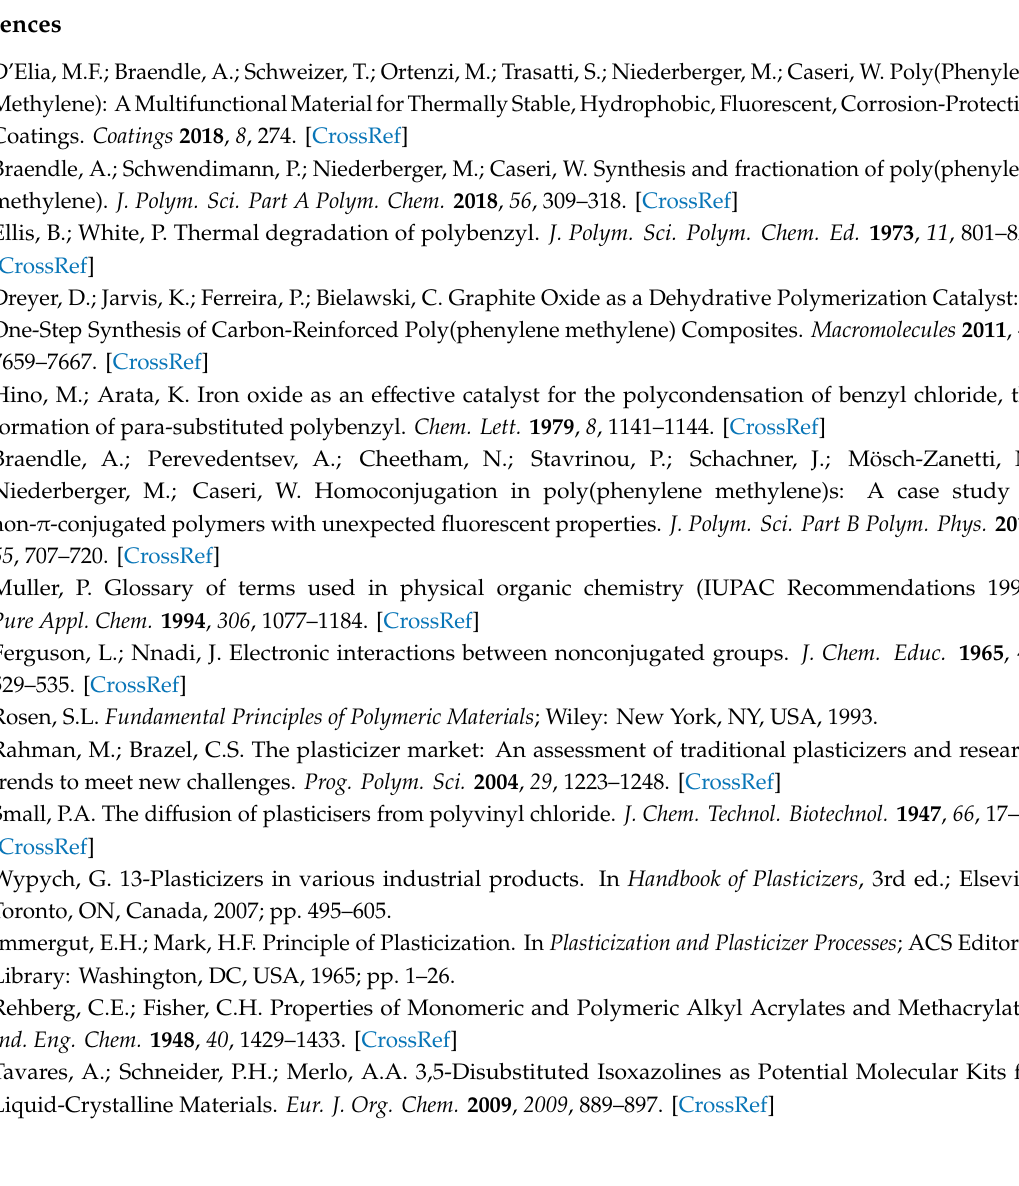
Figure S4: Reproducibility tests (anodic polarization) for sample AA2024 coated with PPM_6.1%-OcOx. Figure S5: Reproducibility tests (anodic polarization) for sample AA2024 coated with PPM_13.4%-OcOx. Figure S6: SEM image of AA2024 coated CO-PPM containing 6.1% mol / mol of 4-octyloxy side chains. Figure S7: SEM image of cross section of a defect on AA2024 coated CO-PPM containing 6.1% mol / mol of 4-octyloxy side chains after polarization. Figure S8: SEM image of AA2024 coated CO-PPM containing 13.4% mol / mol of 4-octyloxy side chains which shows a uniform and homogenous surface even after polarization (top view). Figure S9: SEM image of cross section of AA2024 coated CO-PPM containing 13.4% mol / mol of 4-octyloxy side chains after polarization. Figure S10: Anodic polarization curves for AA2024 coated with PPM_13.4%-OcOx at 35 ◦ C. Figure S11: optical microscope pictures of PPM_13.4%-OcOx under 24h polarization at 0 V vs.